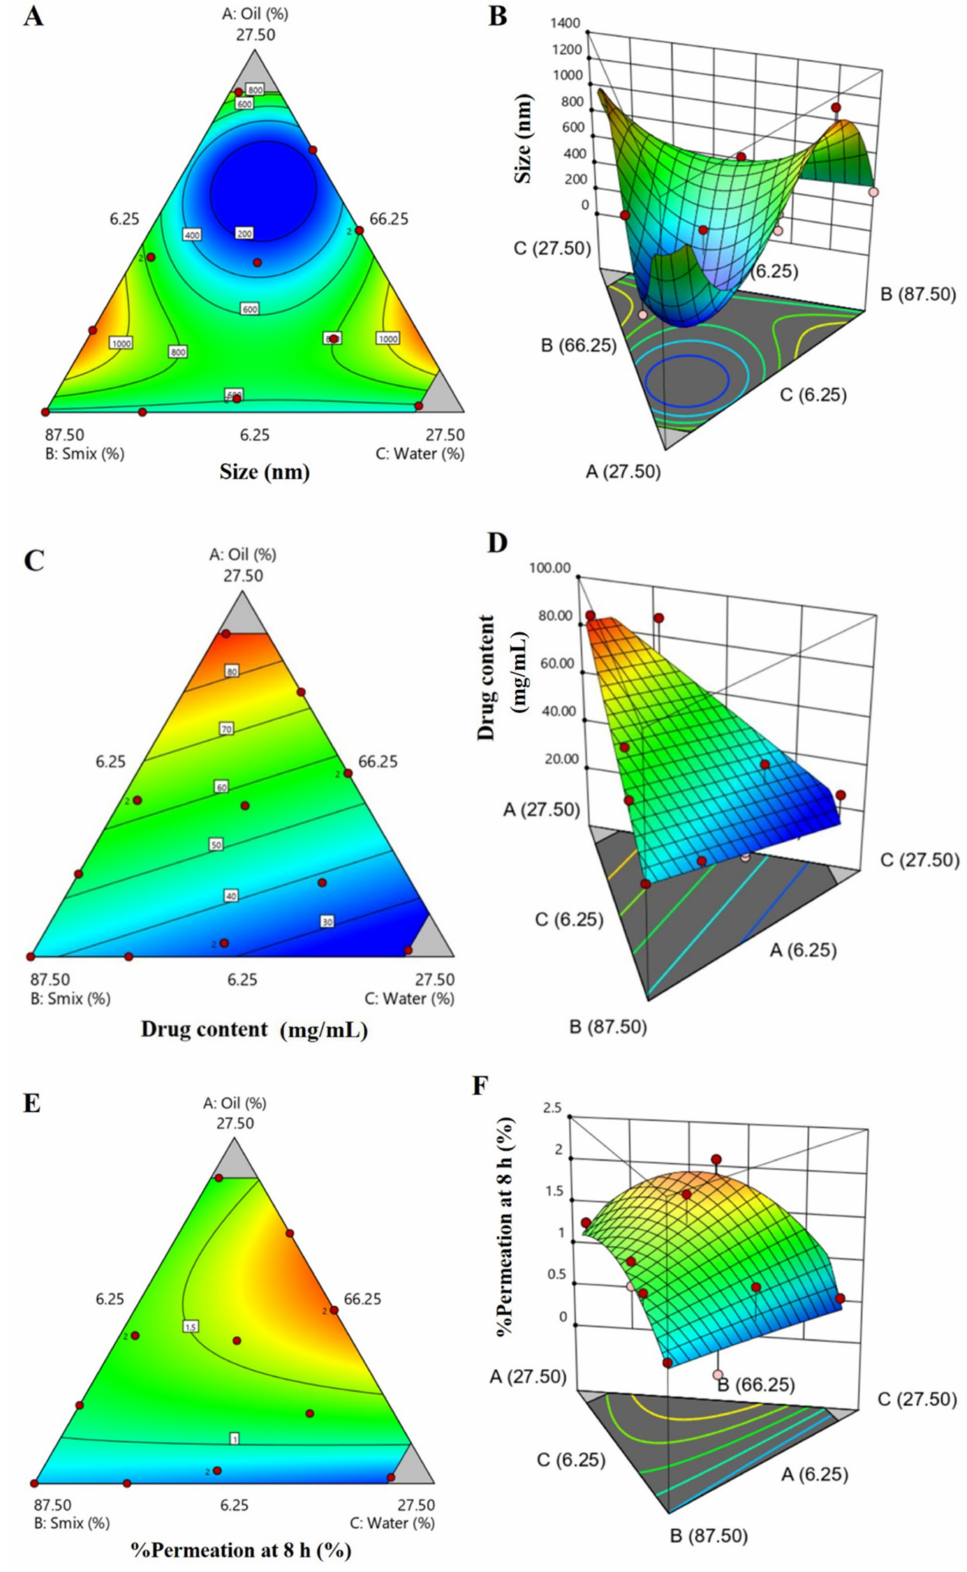
Figure 3. 2D contour plot and 3D response surface area of ( A , B ): size; ( C , D ): drug content; and ( E , F ): % of permeation at 8 h of FLUZ-loaded MEs